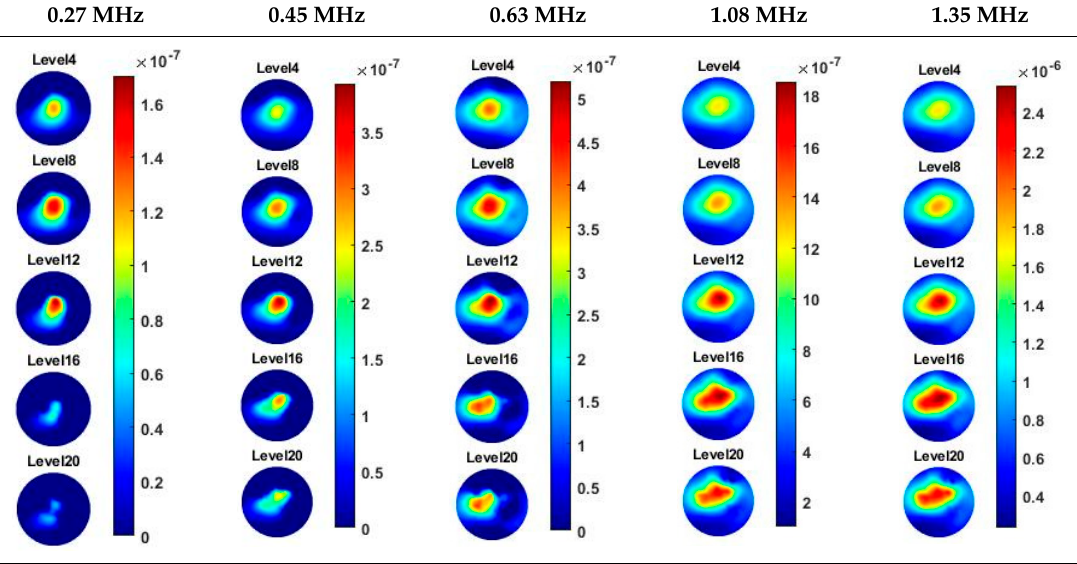
Table 2. Sliced image of horizontal layer for single garlic sample with multi-frequency.